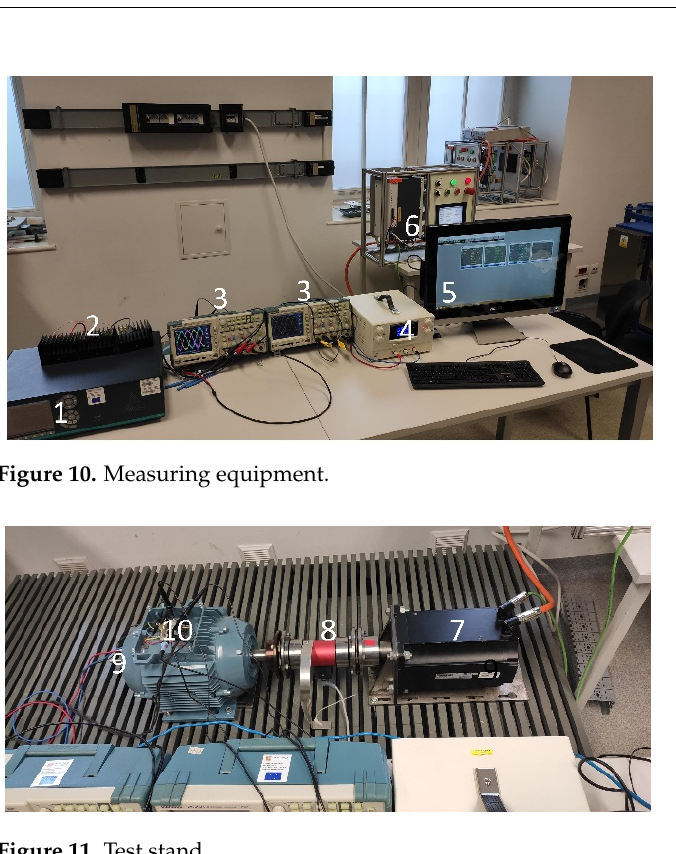
Figure 11. Test stand.